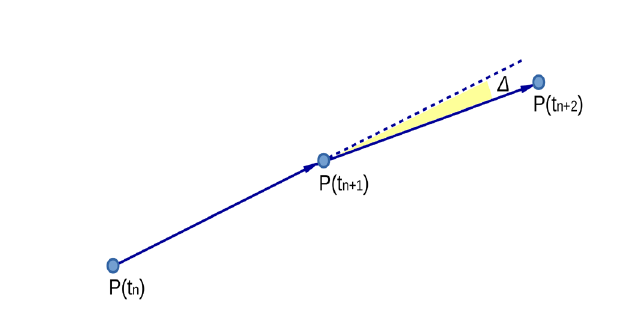
Figure 6. Trajectory categorization criteria. An example of small angle variation Δ designating a straight gesture gestalt. Depending on the system frame rate, P(t n ) is the detected light position at the discrete time t n .